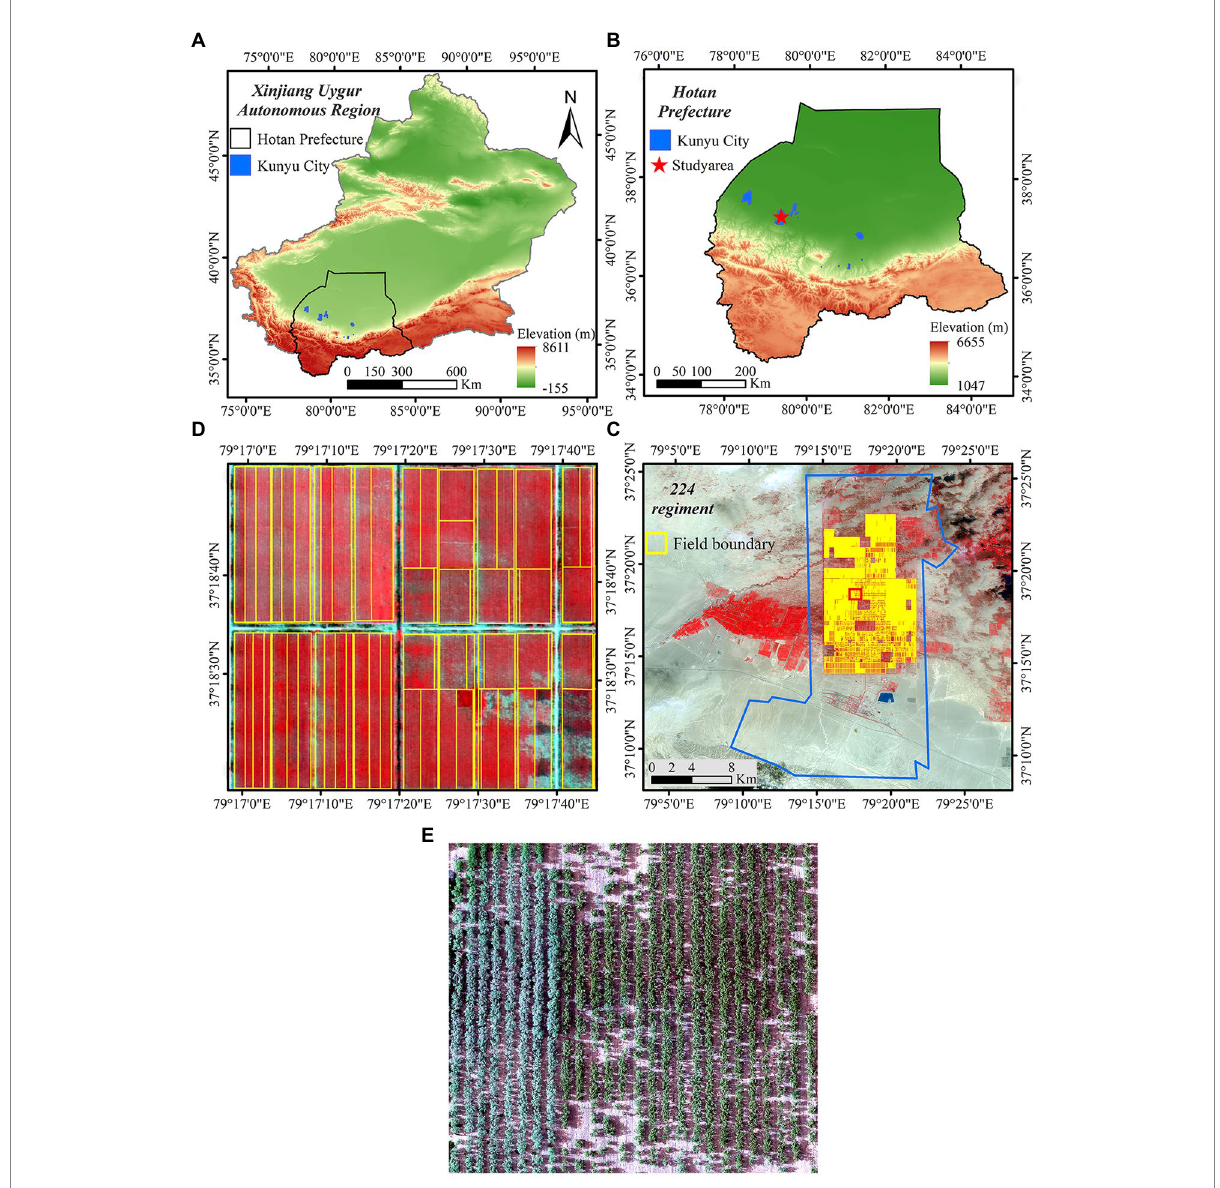
FIGURE 1 Study area. (A) Xinjiang Uygur Autonomous Region; (B) Hotan area; (C) 224th regiment; (D) and (E) Image of the study